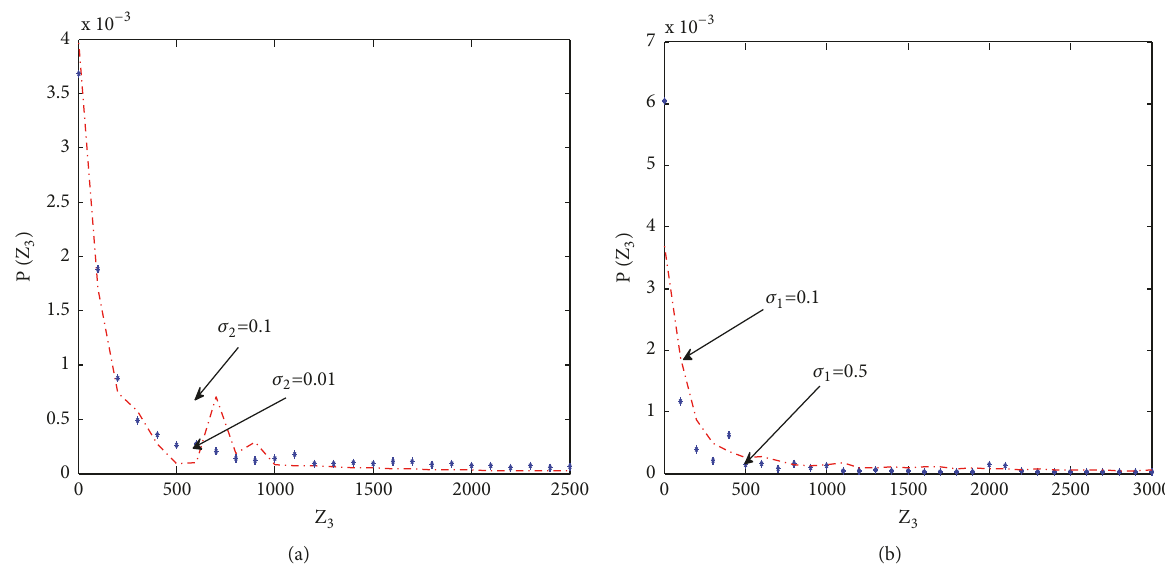
Figure 6: The stationary marginal probability density of virus particles 𝑍 3 (𝑡) . (a) 𝜎 1 = 0.1 is fixed with 𝜎 2 = 0.1 and 𝜎 2 = 0.01 . (b) 𝜎 2 = 0.01 is fixed with 𝜎 1 = 0.1 and 𝜎 1 = 0.5